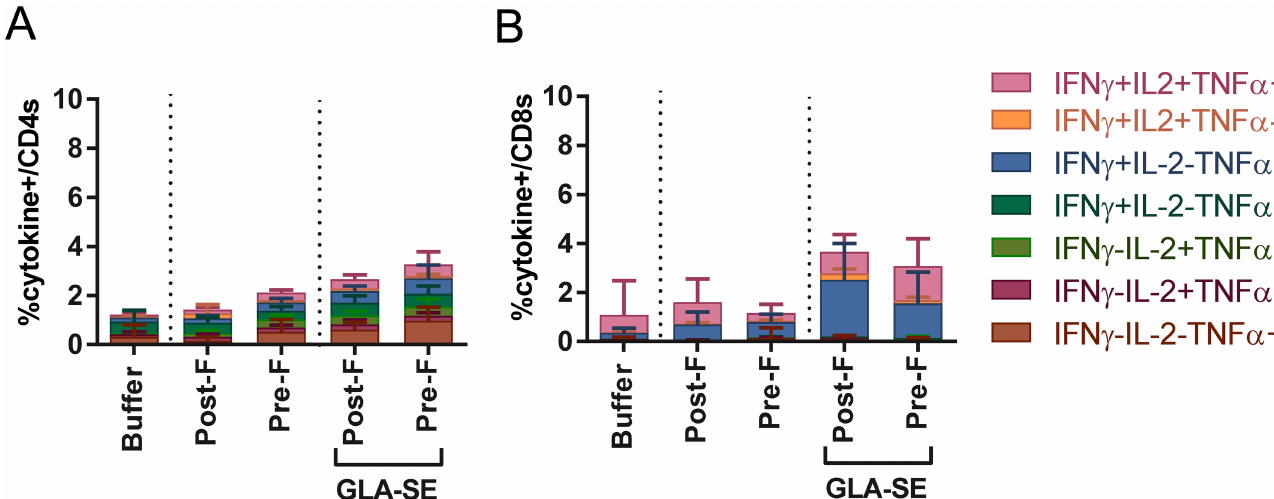
Fig 8. Lung T cell profile of aged seropositive mice following immunization with different RSV F formulations and post challenge with RSV A2. 12 months old mice were i.n. immunizedwith RSV A2 (10 6 PFU) at day 0 and RSV B (10 5 PFU) at day 60. Aged seropositivemice were then immunizedi.m. at day 176 (18 months old) with buffer alone, post-F or pre-F (0.3 μ g) +/- GLA-SE (2.5 μ g/2%) adjuvant.At day 190, aged seropositive mice were challengedwith RSV A2 (10 6 PFU). 4 days later, lung cells were isolatedand stimulatedwith RSV F peptidepool. Cells were then surface stained for CD3 and CD8, intracellularly stainedfor IFN γ , TNF α , and IL-2, and analyzedon an LSR II for the frequencyof responding (A) CD4+ and (B) CD8+ T cells.